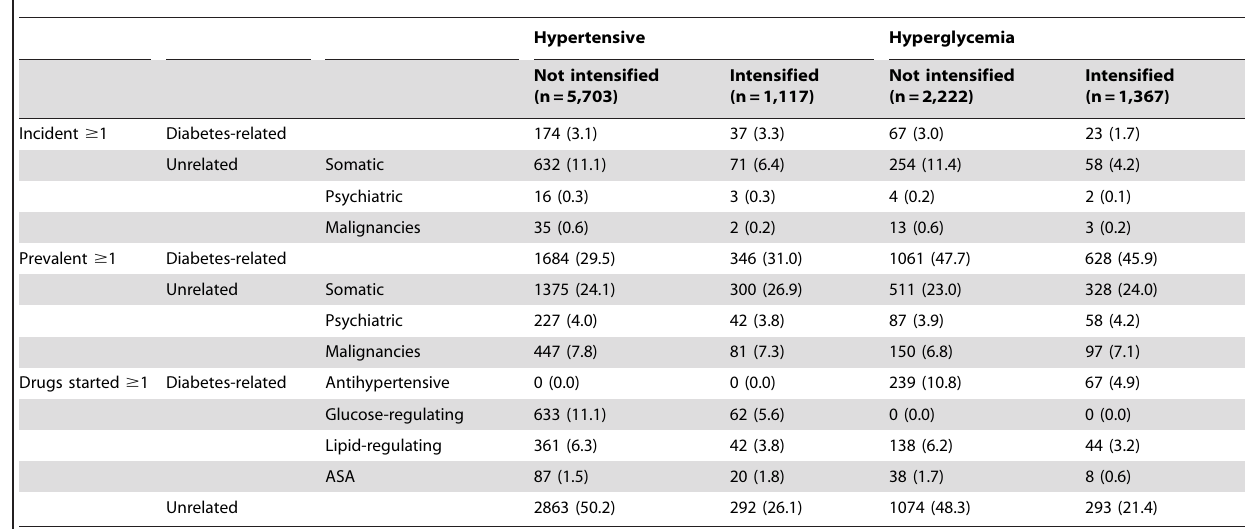
Table 3. Overview of presence of comorbidity, concomitant conditions and events, N (%).